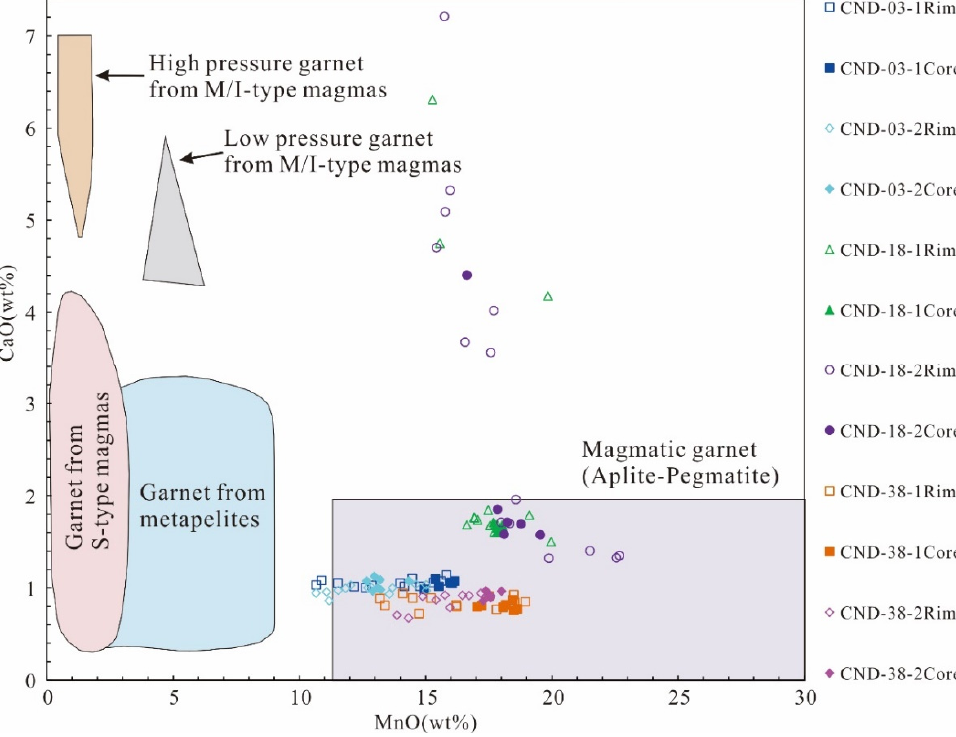
Figure 11. CaO versus MnO (wt%) diagram (modified after [70,77,81,82]). The compositions of garnets from the muscovite granite and pegmatite dominantly lie in the magmatic garnet field (aplite-pegmatite).